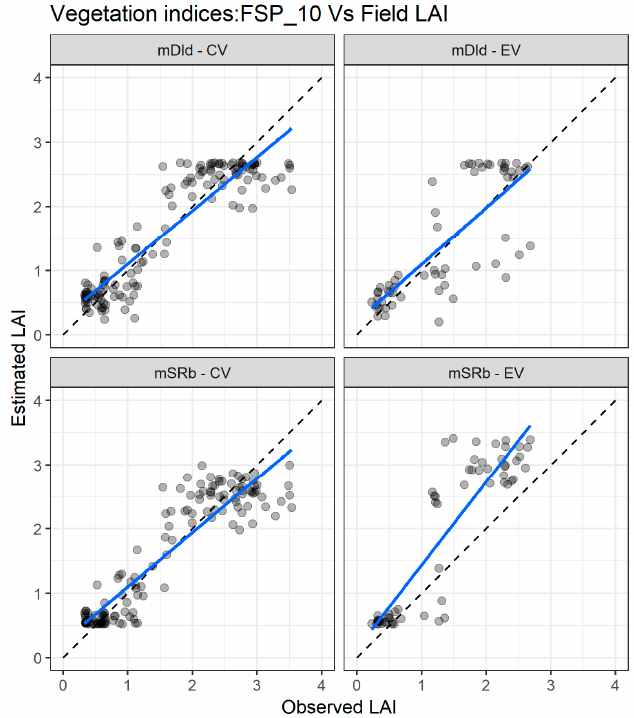
Figure 6. Comparisons between measured and estimated LAI with the two best performing spectral vegetation indices using the FSP_10 dataset for both cross validation (CV) and external validation (EV) datasets. mSR—modified simple ratio; mDI—modified difference index. The full line depicts the linear regression and the dashed line the linear regression through origin.